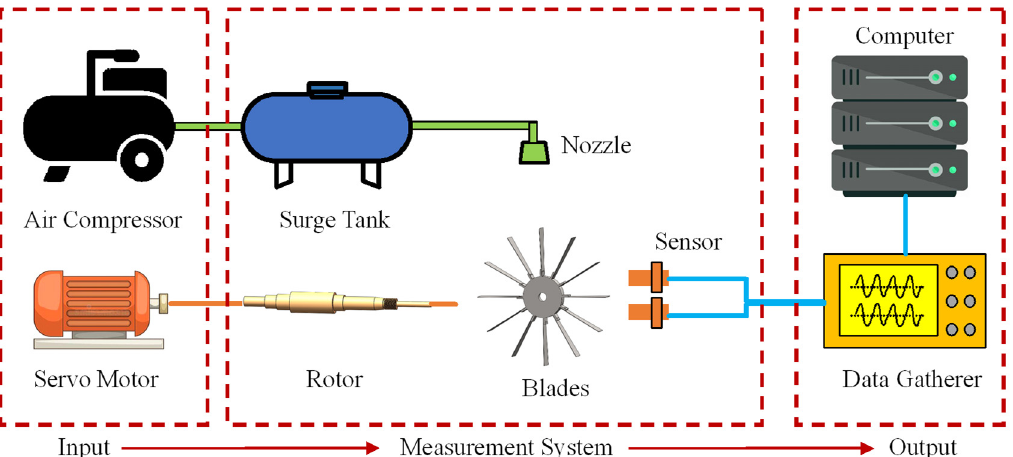
Figure 5. BTT test system structure.